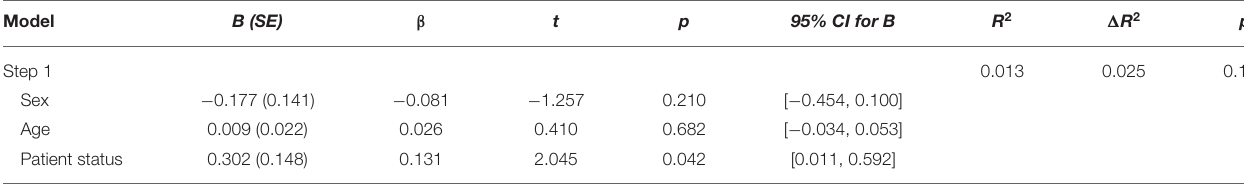
TABLE 6 | Regression analysis: services quality of life.